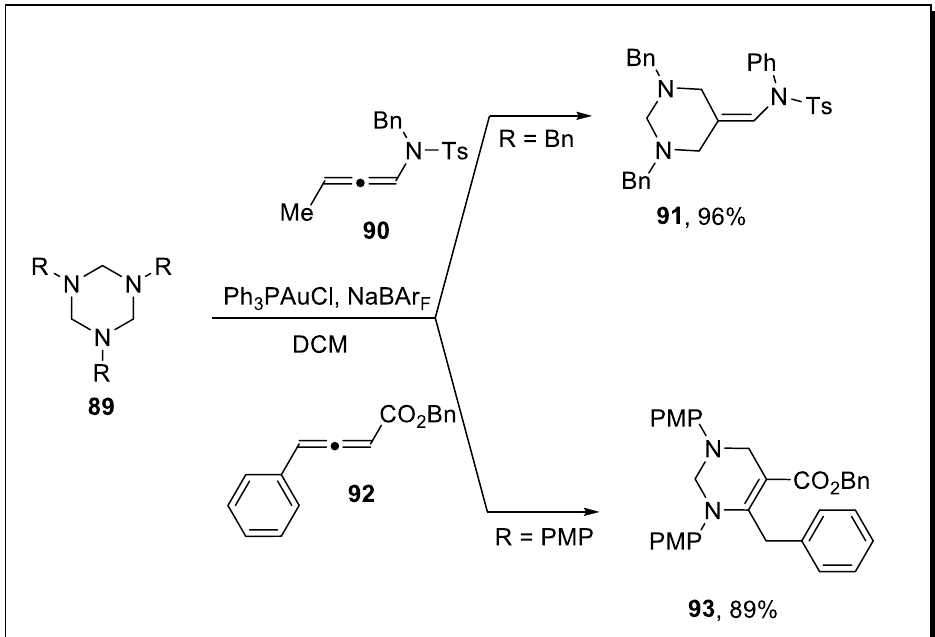
Scheme 28. Au-catalyzed functionalization of 6-membered N -heterocycles 91 and 93 . Polycyclic aromatic compounds were synthesized from the cyclization of propargyl carbonates or esters with furan-ynes via gold catalysis by Liu and co-workers [57]. The